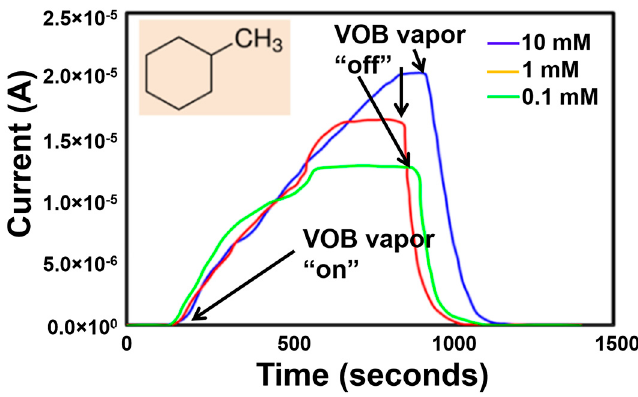
Figure 6. Sensor current response of Ni-TNA to vapors of methylcyclohexane at varying concertation in ethanol solution, arrows show the point when the sensor exposure to the VOB was started and removed.